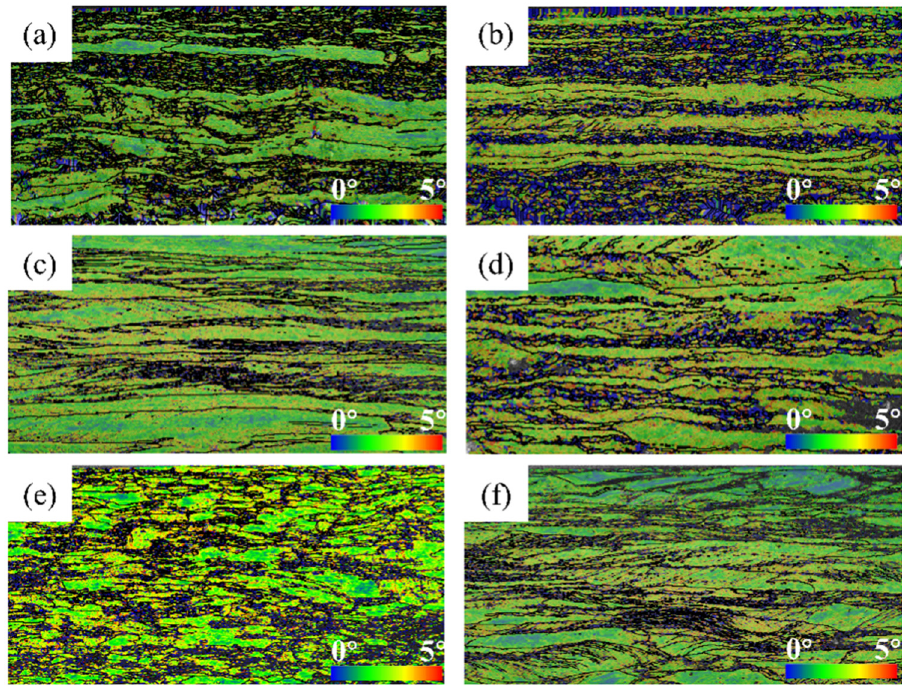
Figure 5: Corresponding KAM distribution diagram of di ff erent deformations: ( a ) 86% Y - free; ( b ) 86% Y - bearing; ( c ) 72% Y - free; ( d ) 72% Y - bearing; ( e ) 60% Y - free; ( f ) 60% Y - bearing.